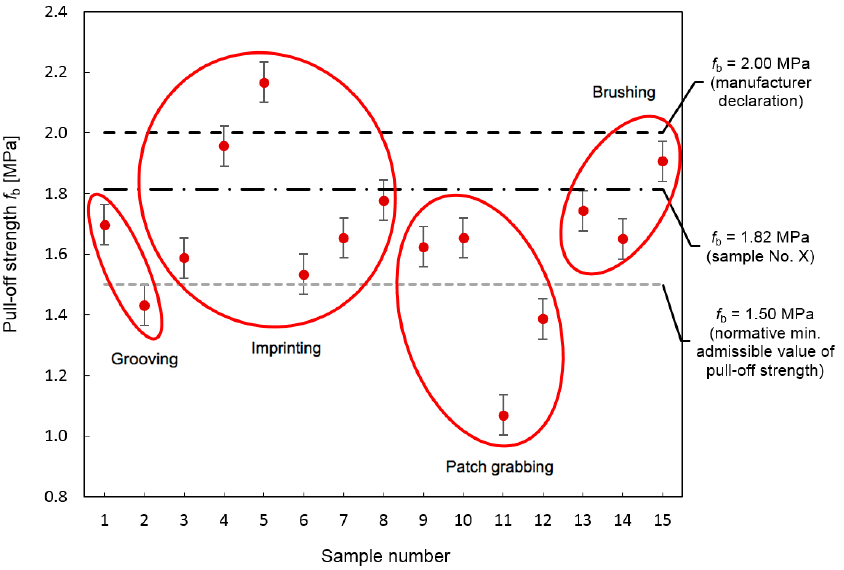
Figure 9. The effect of texturing of the surface of the concrete substrate on the pull-off strength of the epoxy resin coating.